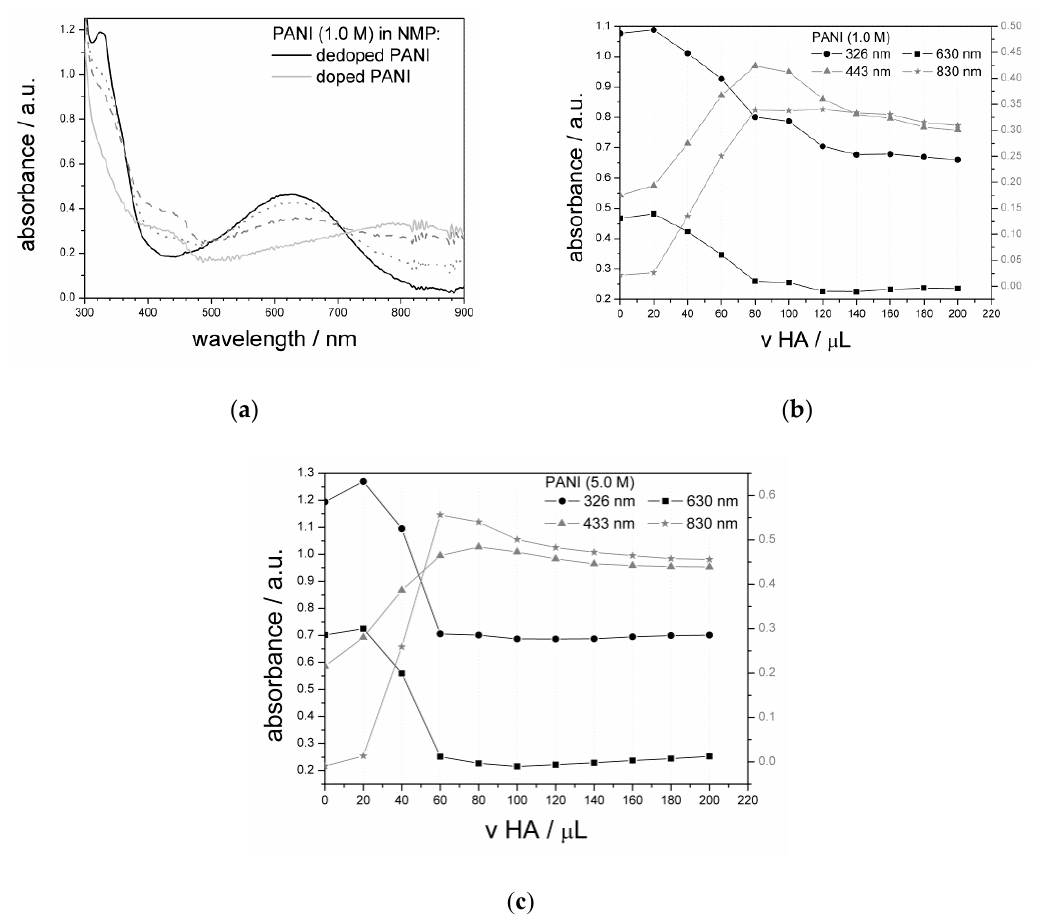
Figure 3. Electronic spectra of dispersion of PANI in N -methyl pyrrolidone (NMP): ( a ) spectra for PANI (1.0 M); ( b , c ) absorbance variation at chosen characteristic wavelengths during titration experiment for ( b ) PANI (1.0 M) and ( c ) PANI (5.0 M) (with H 2 SO 4 denoted as HA).